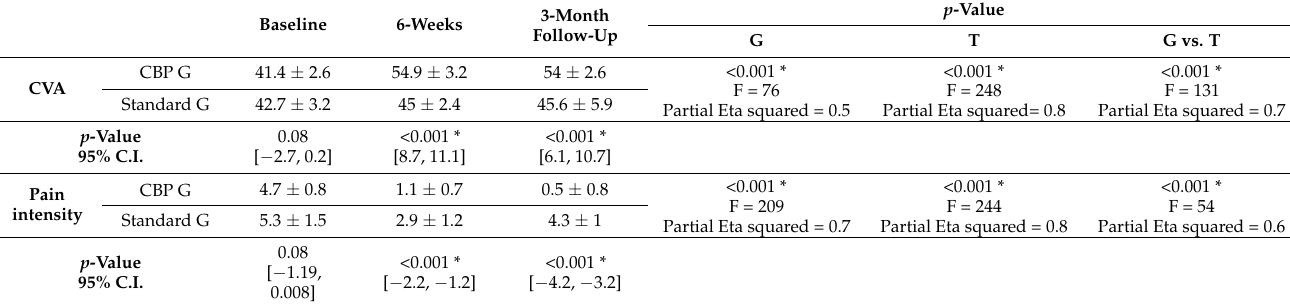
Table 2. The changes in pain and CVA in both groups vs. time. CBP = CBP group; standard = standard exercise groups; CVA= craniovertebral angle; pain intensity is 0–10 where 0 is no pain and 10 is incapacitated; G = group; T = time; G vs. T = group vs. time; all values are expressed as means ± standard deviation; [] = 95% confidence interval; p -Value = statistical significance; * = statistically significant